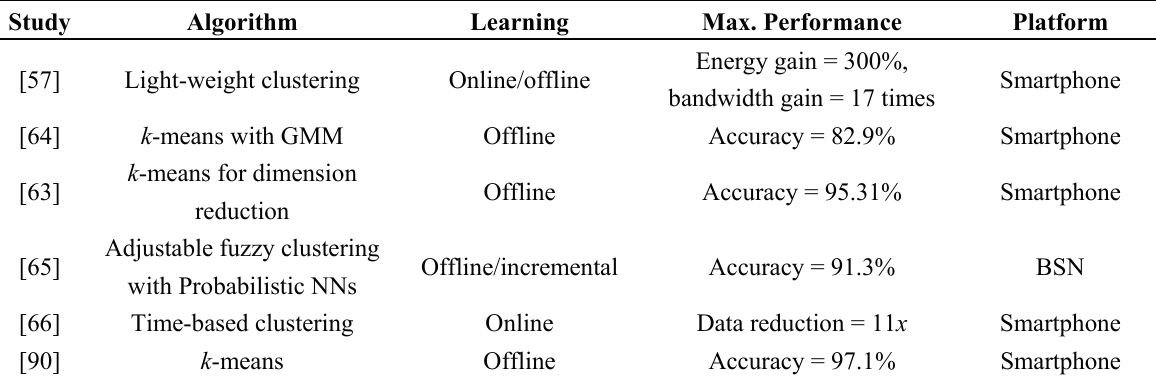
Table 5. Clustering algorithms in